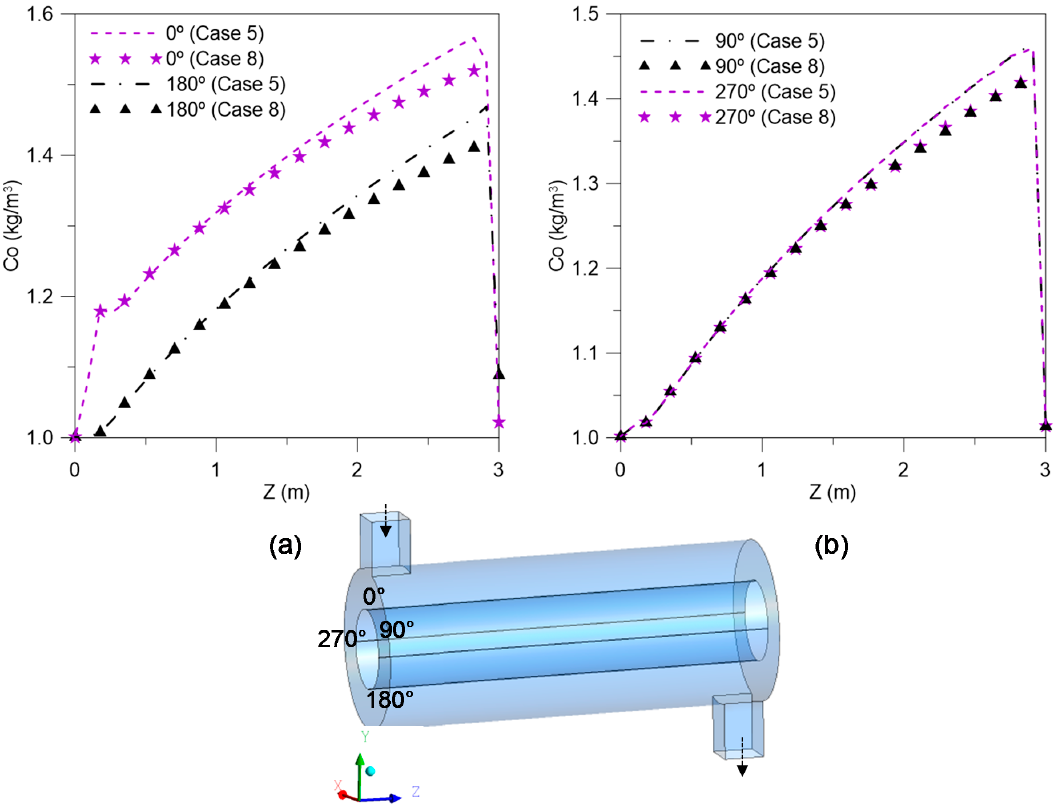
Figure 6. Concentration profile inside the separation module, at the angular positions ( a ) 0 ◦ and 180 ◦ , and ( b ) 90 ◦ and 270 ◦ (Cases 5 and